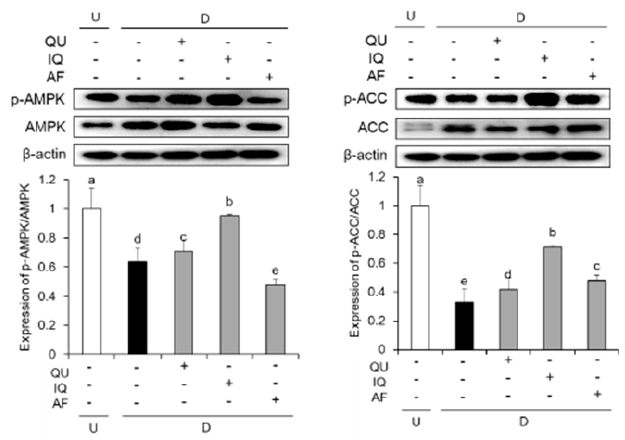
Figure 7. Effects of flavonoids from Acer okamotoanum (10 µg/mL) on AMPK signaling in differentiated 3T3-L1 cells. Adipocyte differentiation was induced by treatment with MDI media in the absence or presence of flavonoids from A. okamotoanum during 2 days. The MDI media was then replaced with insulin media, and it was changed four times for every 2 days. Data are expressed as the mean ± standard deviation. a–e Means with different letters indicate significant differences ( P < 0.05) by Duncan’s multiple range test. β -actin was used as a loading control.